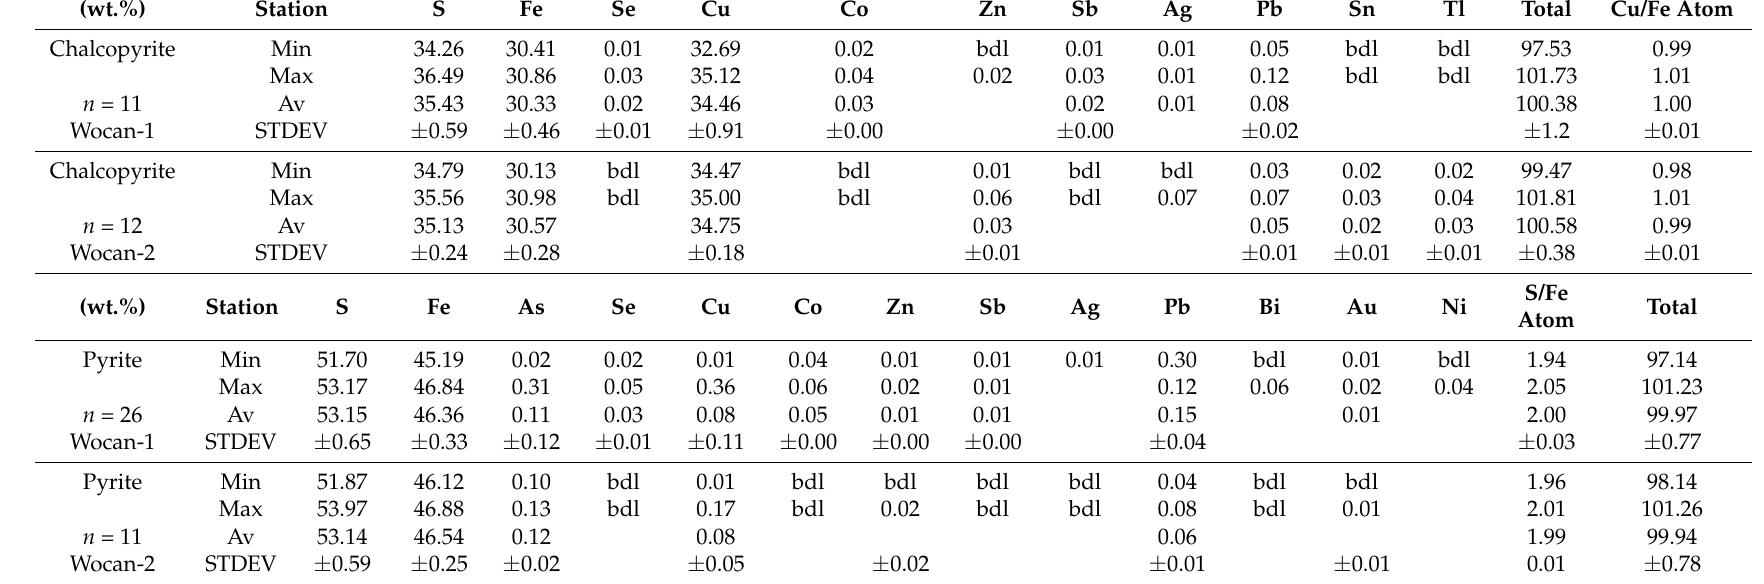
Table 4. Micro-chemical (EPMA) compositions of chalcopyrite and pyrite